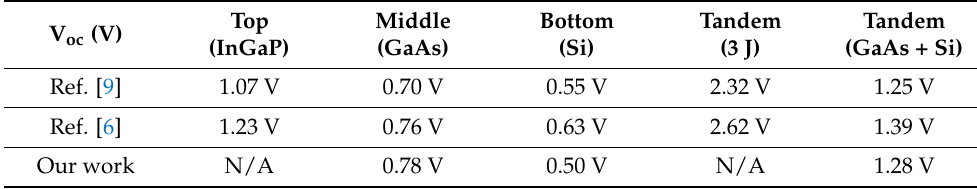
Table 2. Comparison of GaAs/Si tandem cell